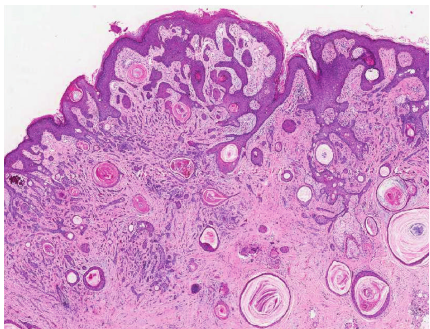
Figure 11: Desmoplastic trichoepithelioma: low power magnifica- tion showing hyperplastic downgrowths of epidermis with cords of basaloid tumor cells arranged in a pseudoinfiltrative pattern. (H&E, × 40). 2.5. Eccrine Squamous Syringometaplasia. Eccrine squamous